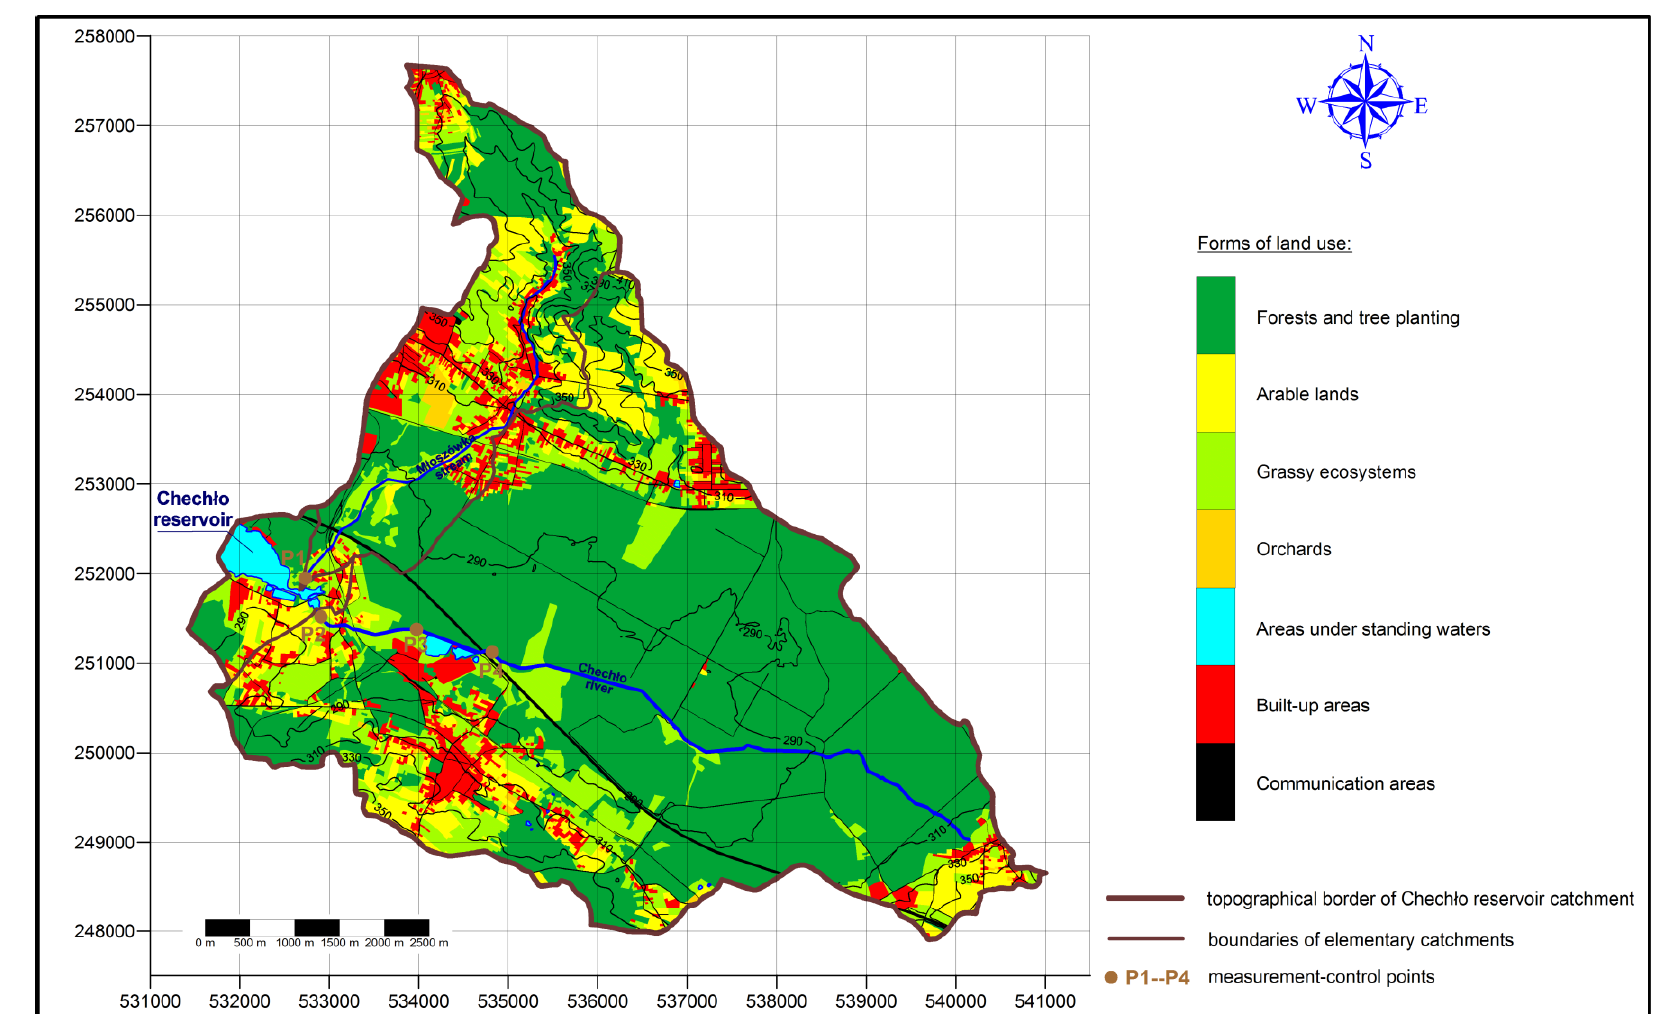
Figure 2. Land-use map of research catchments.